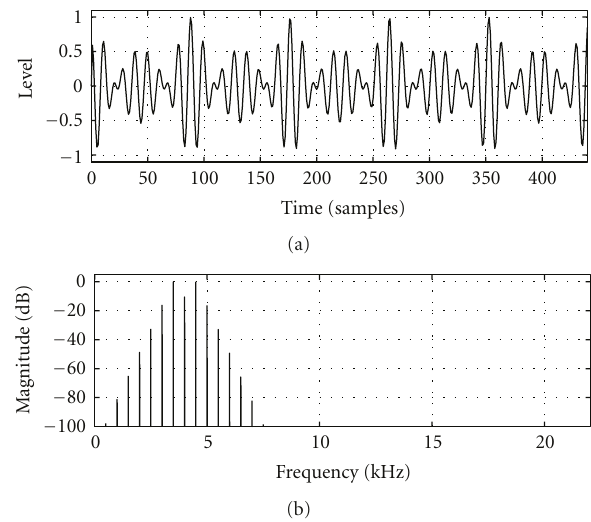
Figure 13: Heterodyne FBAM variation 3-I ( f 0 = 500Hz, β = 0 . 2, modulator frequency 4000 Hz (8:1 ratio)), see Figure 10(c).